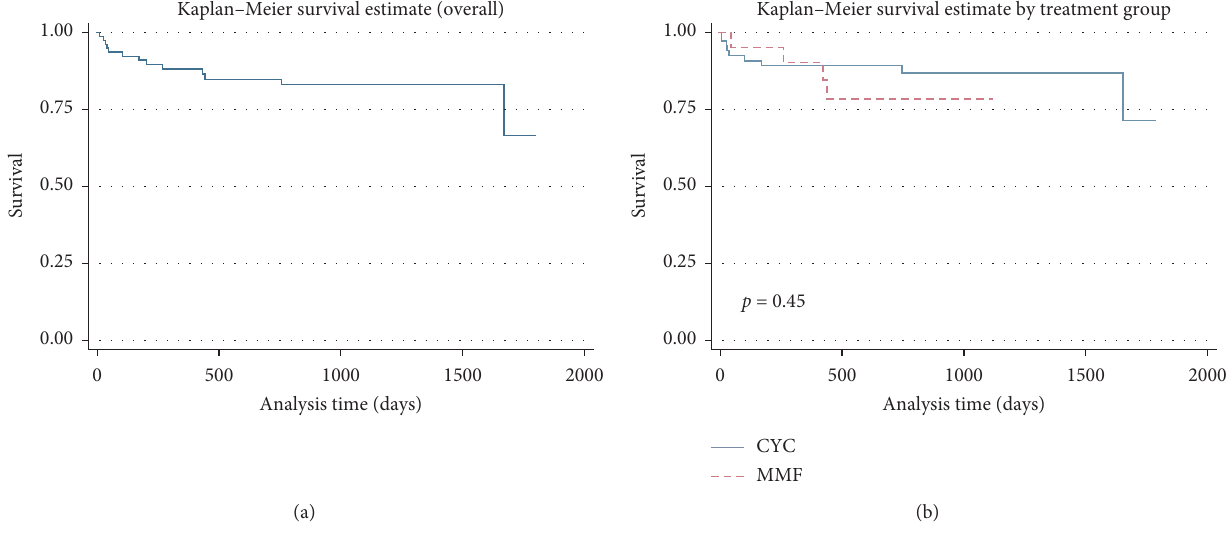
Table S1: sensitivity analysis showing multivariable models for the predictors of remission and mortality. ( Supple- mentary Materials )